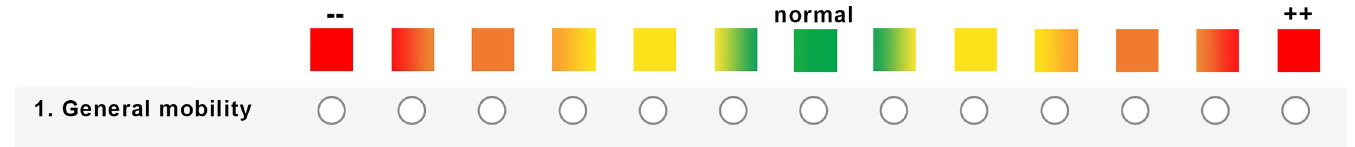
Fig 2. Example of a coloured bar with tick boxes for evaluating general mobility of the back (for analysis the score was given a value of 1 to 13. e.g., the left tick box was labelled with 1 (no movement (—)), the middle with 7 (normal mobility), and the right one (severe hypermobility (++)) with 13).